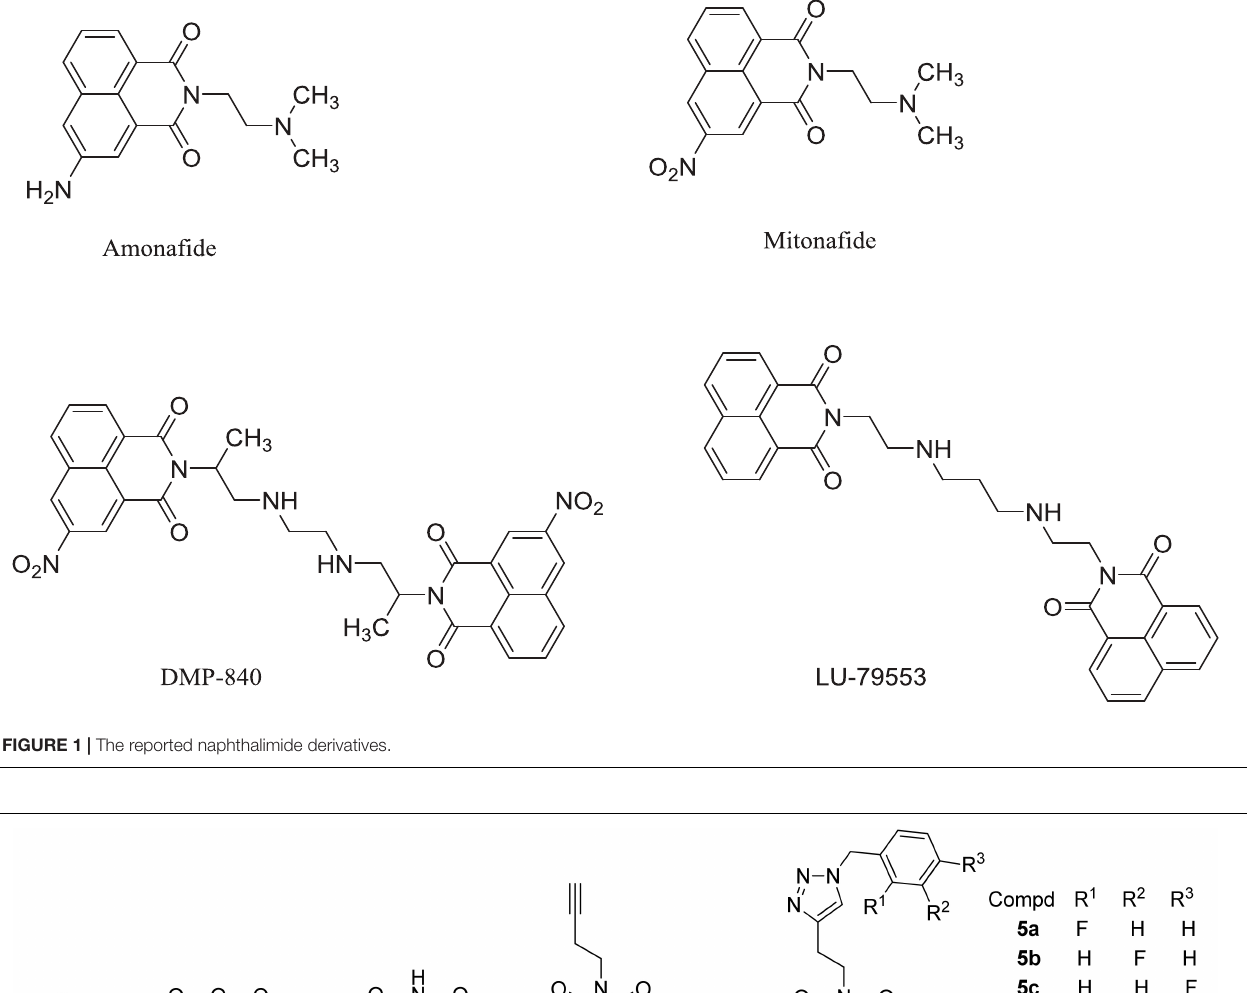
Frontiers in Bioengineering and Biotechnology |